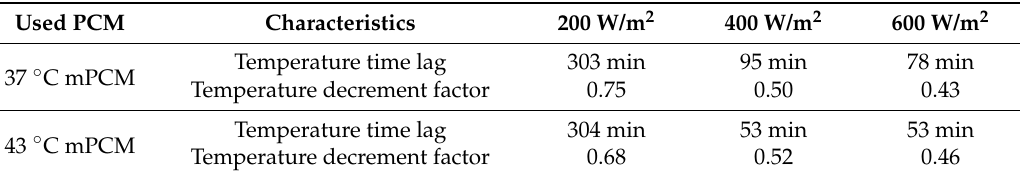
Table 1. Temperature time lag and temperature decrement factor of each experimental during the